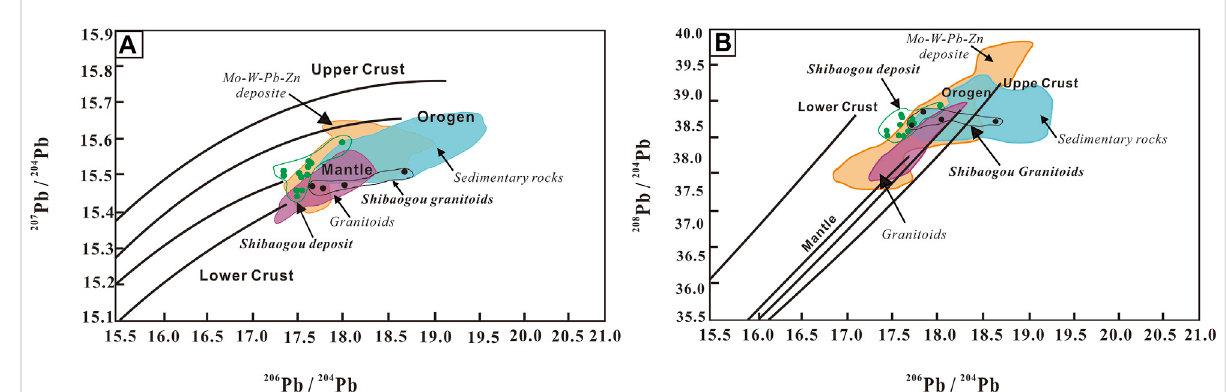
FIGURE 12 Plot of 207 pb/ 204 pb vs. 206 pb/ 204 pb (A) and 208 pb/ 204 pb vs. 206 pb/ 204 pb (B) for the Shibaogou sul fi des, local granitoids, and host rocks. Pb isotope compositions of sul fi des in the Shibaogou deposit. Pb isotope compositions in the Mo – W – Pb – Zn deposits of the Luanchuan ore district are after Huangetal.,1984;Luoetal.,1991;Yan,2004;Qi,2006;Yanetal.,2009;Duanetal.,2011;Caoetal.,2015;Yangetal.,2017.Pbisotopecompositions causativegranitoidsarecitedfromHuangetal.,1984;Luoetal.,1991;Guo,2018.GalenaisotopevaluesofsedimentaryrocksarefromLiuetal., 2007; Yan et al.,